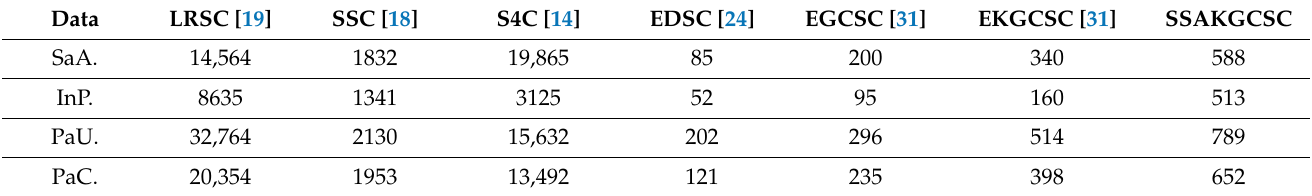
Table 7. Running time of different methods (in